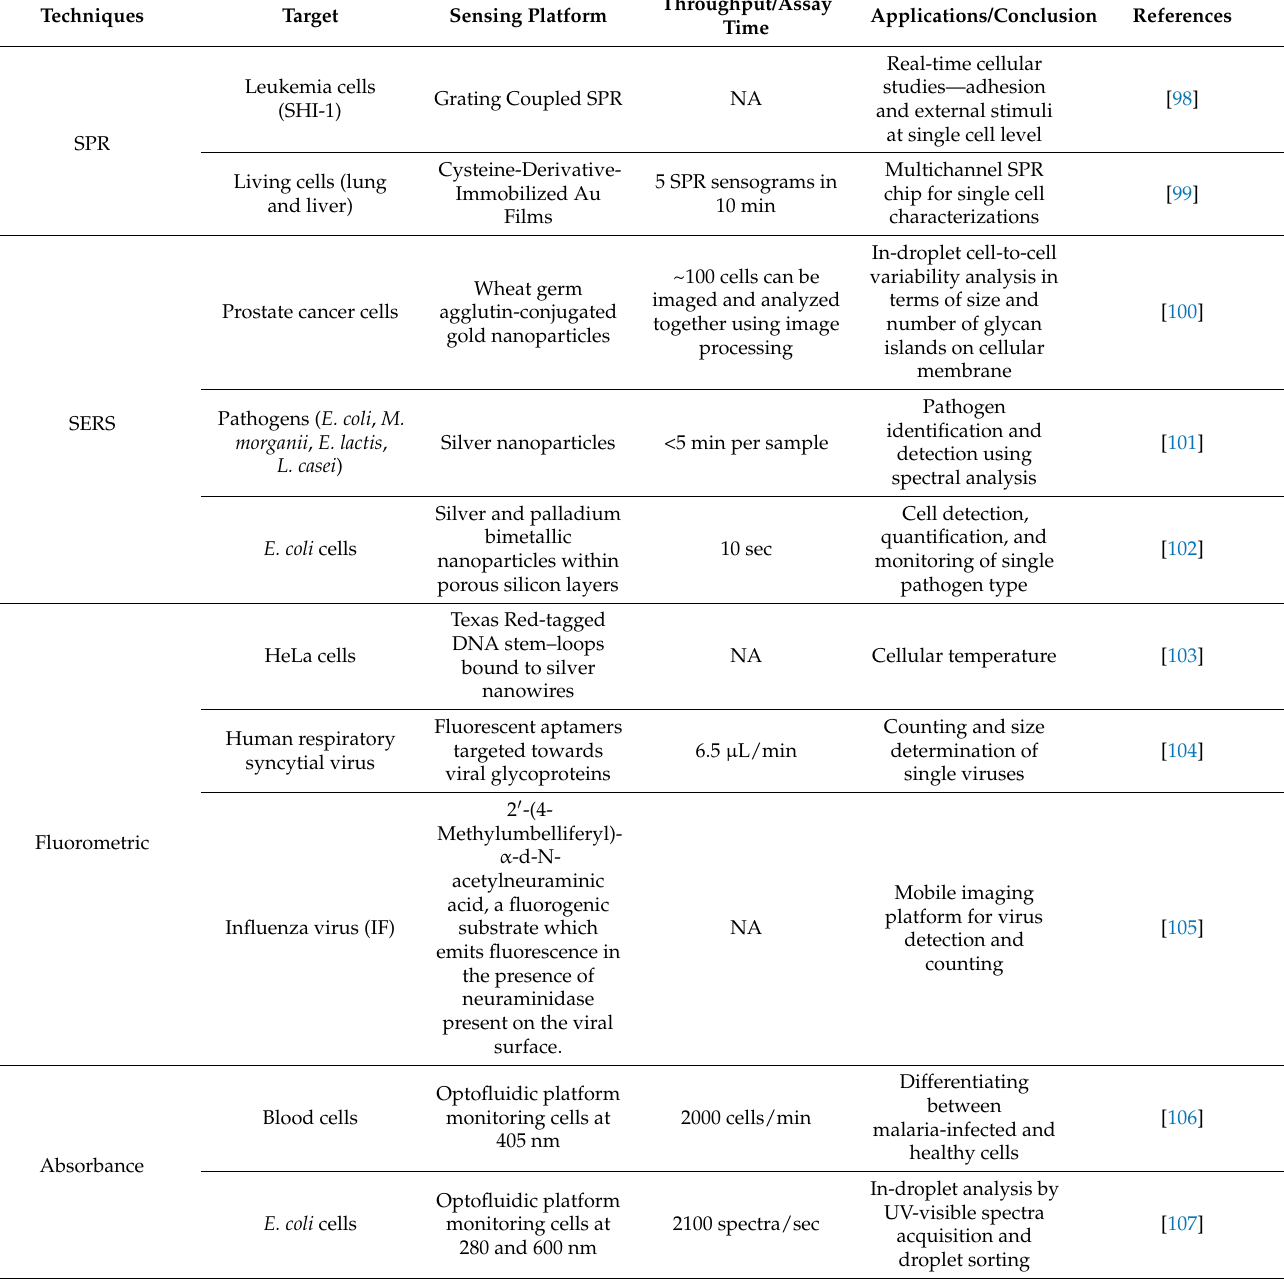
Table 1. Single cell analysis using optical detection